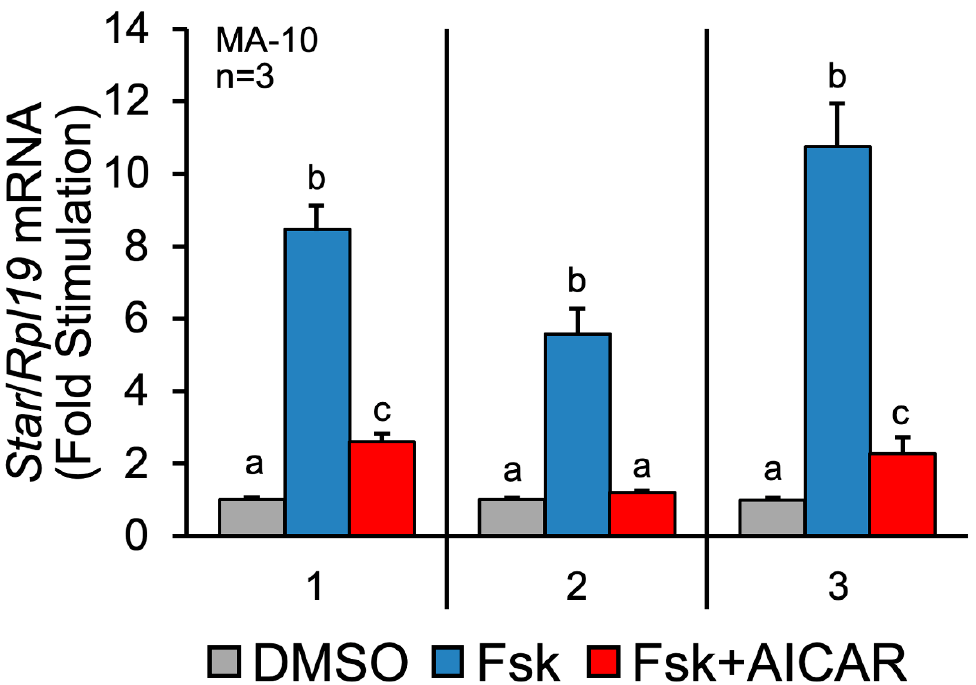
Figure 1. Validation of treatments on MA-10 Leydig cells by assessing Star mRNA levels. MA-10 Leydig cells were treated with either DMSO (control, grey bars), Forskolin alone (Fsk, 10 µM, blue bars) or Forskolin and AICAR (Fsk+AICAR, 10 µM, and 1 mM, respectively, red bars) for 1 h. Total RNA was extracted and reverse-transcribed, and qPCR was performed to quantify Star mRNA levels. Rpl19 was used to normalize the data. The numbers on the x-axis refer to the three different samples used in the LC-MS/MS analysis. Results are displayed as the mean of three individual experiments, each performed in duplicate. For a given experiment, different letters indicate a statistically significant difference between groups ( p < 0.05).